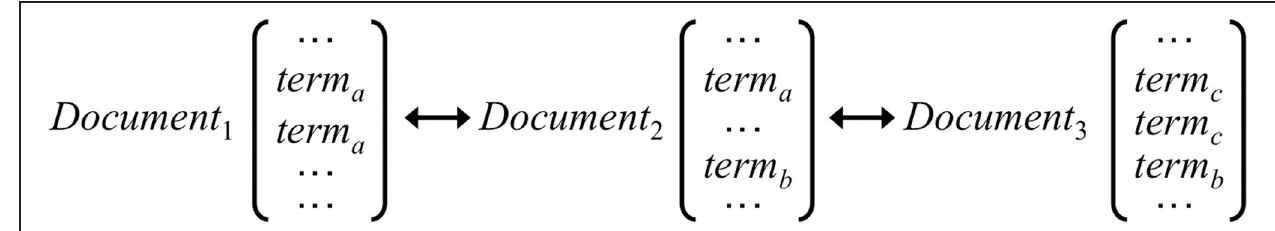
FIGURE 2 | An illustration of a “latent” link between term a and term c because of their respective co-occurrence with term b . The principle of Swanson discovery is analogous to this—we have two currently disjointed sets of literature A and C and bridge the gap by introducing an intermediate literature set B.